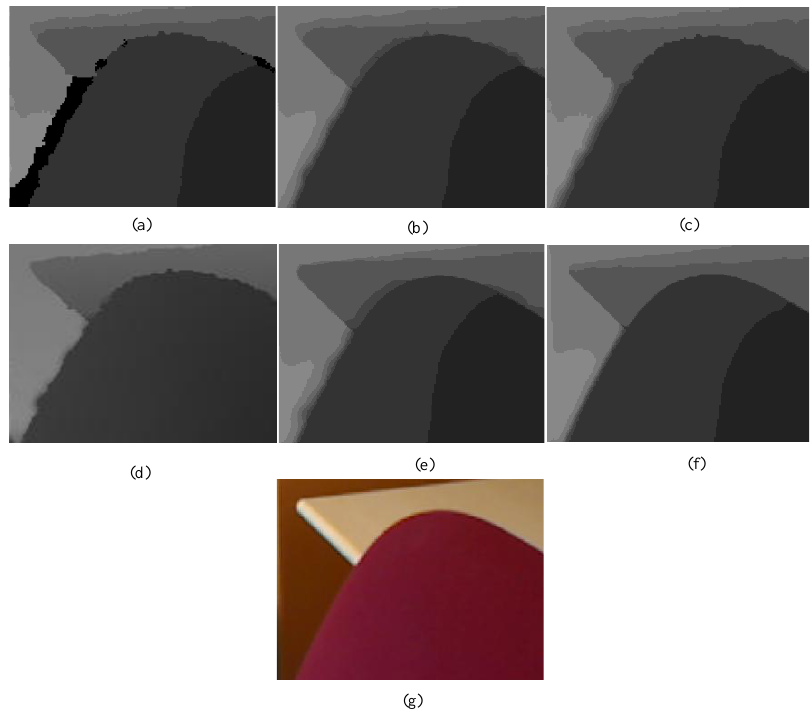
Figure 12. Zoomed-in results for Figure 10: ( a ) Original; ( b ) JBF;( c ) FMI; ( d ) GFMI; ( e ) GFMIGF; ( f ) Proposed method; ( g ) Color image.